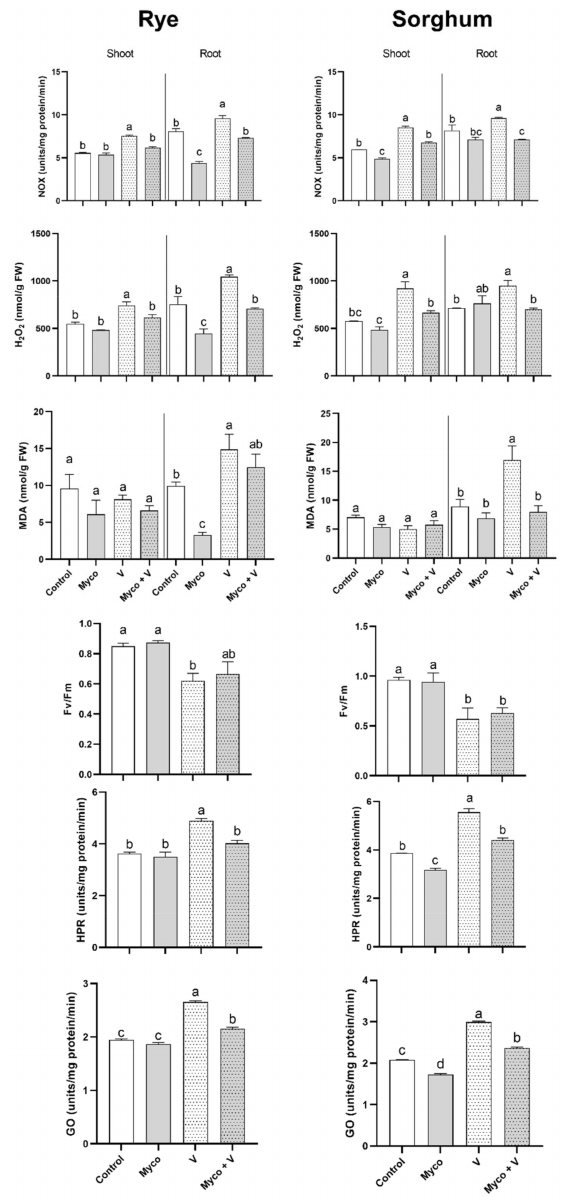
Figure 3. Changes in oxidative stress parameters (NOX, H 2 O 2 , and MDA) in shoots and roots and photorespiration enzymes (F v /F m ratio, HPR and GO) in shoots of six-week-old rye and sorghum grown in soils with 0 or 350 mg/kg soil sodium vanadate and with or without soil enrichment with inoculum of the mycorrhiza Rhizophagus irregularis . Data are mean values ± SE ( n = 3). Data were statistically analyzed by one-way ANOVA followed by Tukey’s posthoc test for comparing the means. Different letters indicate statistically significant difference between means of the same plant species at significance level of at least ( p ≤